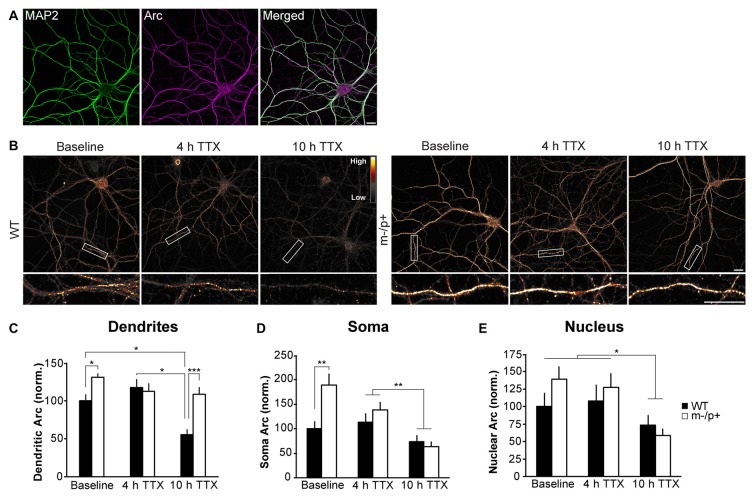
Arc protein is more stable in dendrites of Ube3am−/p+ cultured neurons. Hippocampal neurons were cultured from E18 WT and Ube3am−/p+ mice. At DIV19–21, neurons were treated with tetrodotoxin (TTX) for 4 or 10 h. Neurons were immunostained for Arc and expression analyzed in dendrites, cytoplasm and nucleus (n = 15 neurons/group, two dendrites/neuron). (A) A representative image of MAP2 and Arc immunostaining in a cultured hippocampal neuron. MAP2 was used to choose healthy neurons for imaging in all culture experiments. (B) Images of representative neurons from WT and Ube3am−/p+ cultures at baseline or after 4 or 10 h TTX. To highlight intensity levels, images are shown using the Smart look up table (LUT) generated using ImageJ software. (C) In dendrites, Arc expression was significantly higher in Ube3am−/p+ neurons than WT at baseline. Arc expression declined at 10 h TTX compared to 4 h and baseline in WT neurons, but not in Ube3am−/p+ neurons. Arc levels were higher in Ube3am−/p+ neurons than WT at 10 h TTX. (D) In the cytoplasm, Arc was significantly higher in Ube3am−/p+ neurons than WT at baseline, but after 10 h TTX, Arc expression had significantly decreased in both genotypes. (E) In the nucleus, Arc was lower at 10 h TTX than baseline or 4 h, but there were no genotype differences. Scale bar = 10 μm. *P < 0.05, **P < 0.01, ***P < 0.001.